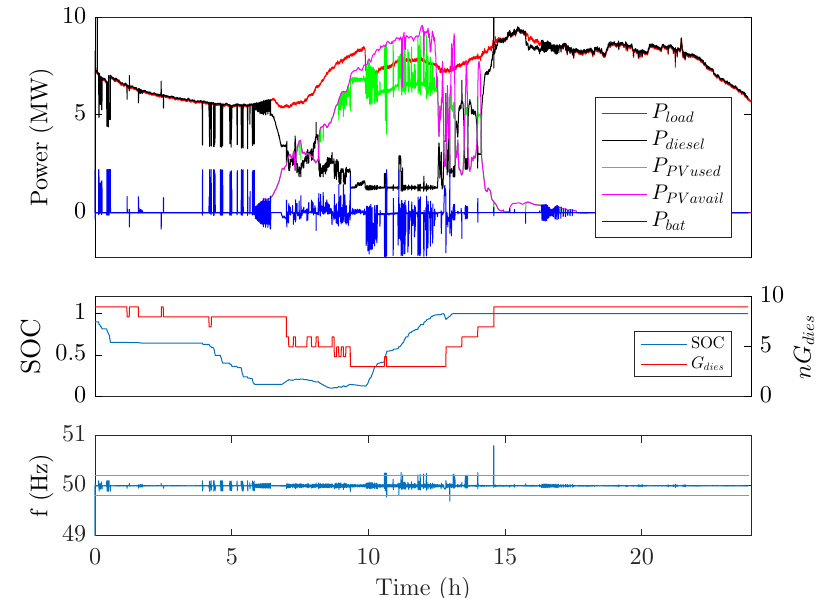
Figure 7. Simulation results for the second scenario (medium PV variability).